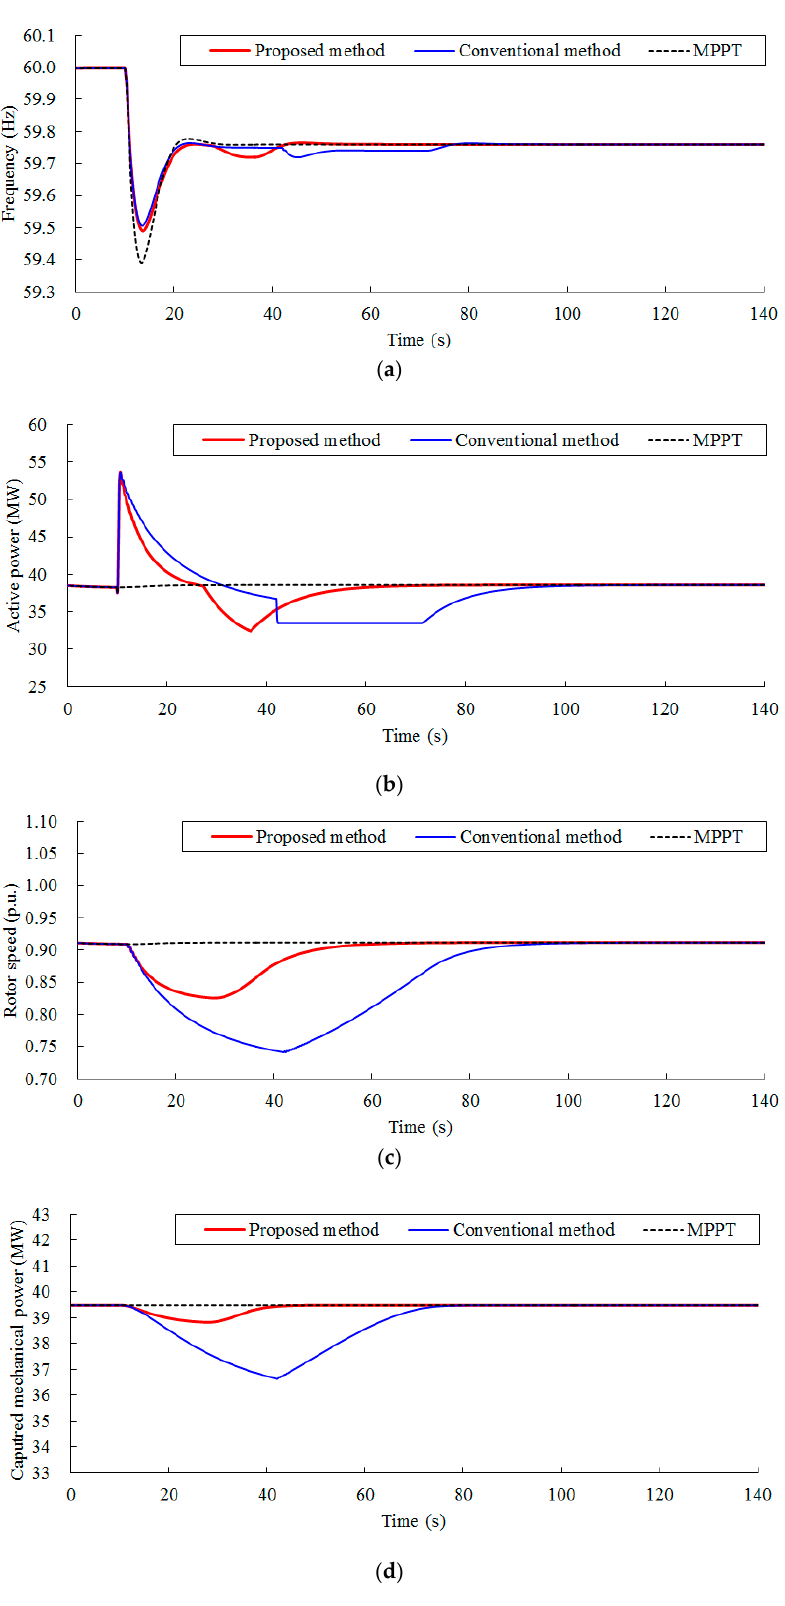
Figure 8. Results for Case 2: ( a ) system frequencies; ( b ) active powers; ( c ) rotor speeds; ( d ) captured mechanical powers.